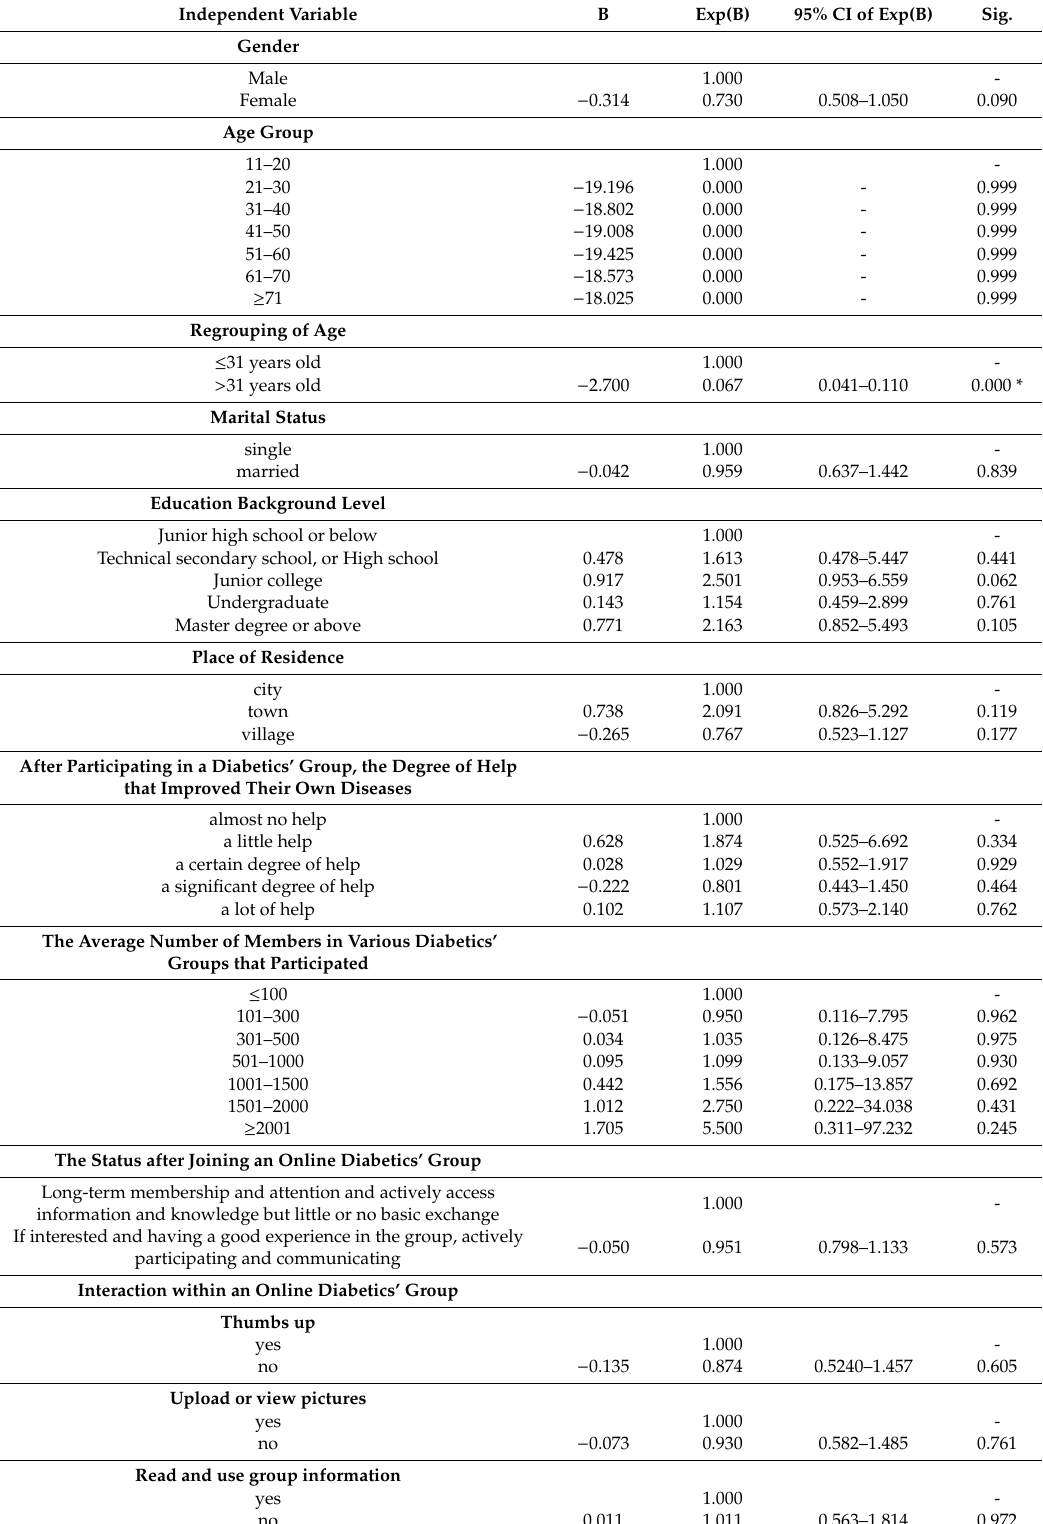
Table 3. The results of univariate binary logistic regression analysis for social support in